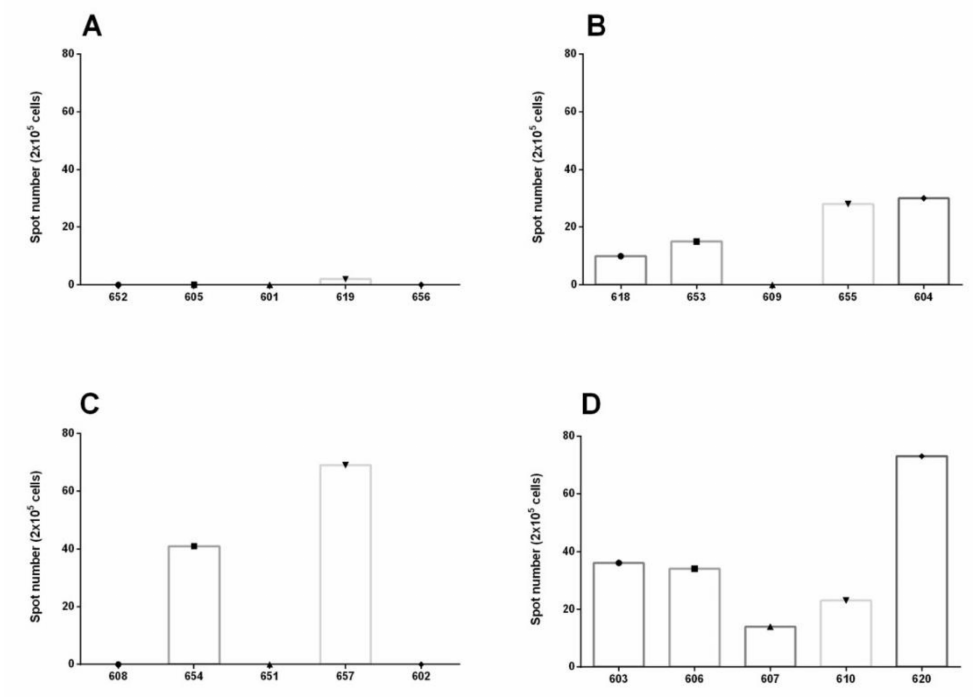
Figure 4. IFN γ reading by ELISPOT. ( A ) Group 1: unvaccinated animals. ( B ) Group 2: animals immunized once five days before challenge. ( C ) Group 3: animals immunized once three days before challenge. ( D ) Group 4: animals immunized once one day before challenge. No statistical differences were detected between the vaccinated groups (Kruskal–Wallis test p >